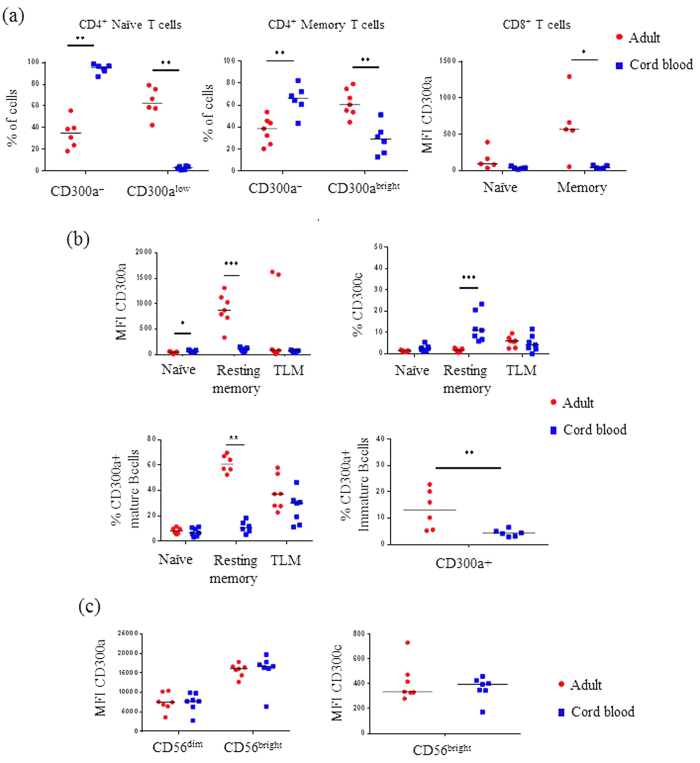
The expression pattern of CD300 surface receptors on lymphocytes is different in neonates from adults.(a) Dot graphs representing the percentage of CD300a− and CD300low cells in CD4+ naïve cells (left), the percentage of CD300a− and CD300abright on CD4+ memory T cells (middle), and the MFI of CD300a expression on CD8+ naïve and memory T cells (right). (b) Dot graphs showing the MFI (upper left) of CD300a expression and the percentage (lower left) of CD300a+ cells in naïve, resting memory and TLM mature B cell subsets, the percentage of CD300c+ cells in naïve, resting memory and TLM mature B cell subsets (upper right), and the percentage of CD300a+ immature B cells (lower right). (c) Dot graphs representing the MFI of CD300a (left) and CD300c (right) expression on CD56dim and CD56bright NK cells is represented. Each dot represents a different donor, and the medians are represented. *p < 0.05, **p < 0.01, ***p < 0.001.